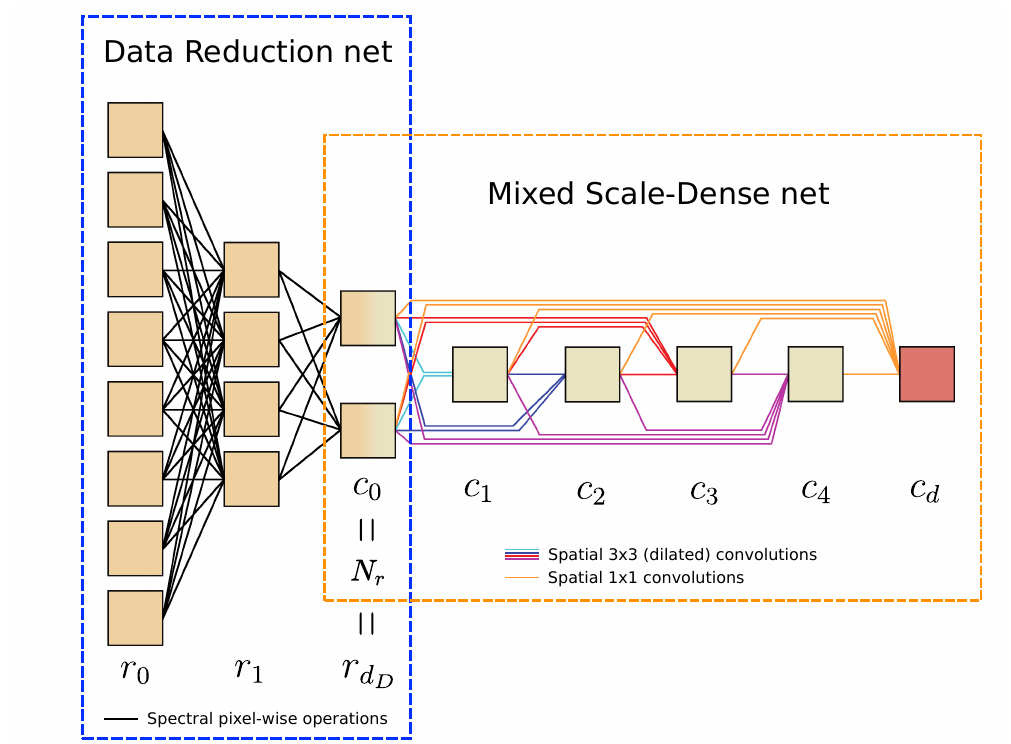
Figure 4. Example of a Data Reduction Mixed-Scale Dense (MSD) network structure. The number of channels are indicated with the feature maps. Since w = 1 is chosen, c i = 1 for i > 0. The data are = N r = c = 2 feature map channels in the data reduction reduced from r 0 = 8 input images to r d 0 D net, while the segmentation task is performed by an MSD net of depth d = 5. Each 3 × 3 convolution is followed by a Rectified Linear Unit (ReLU)